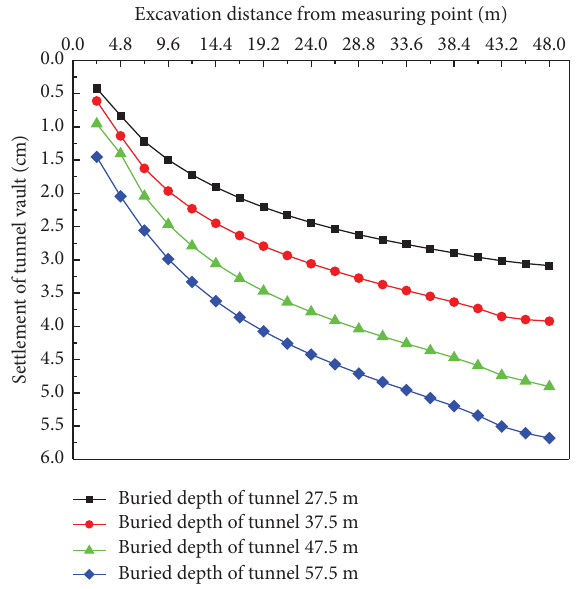
Figure 6: Settlement of tunnel vault with diferent buried